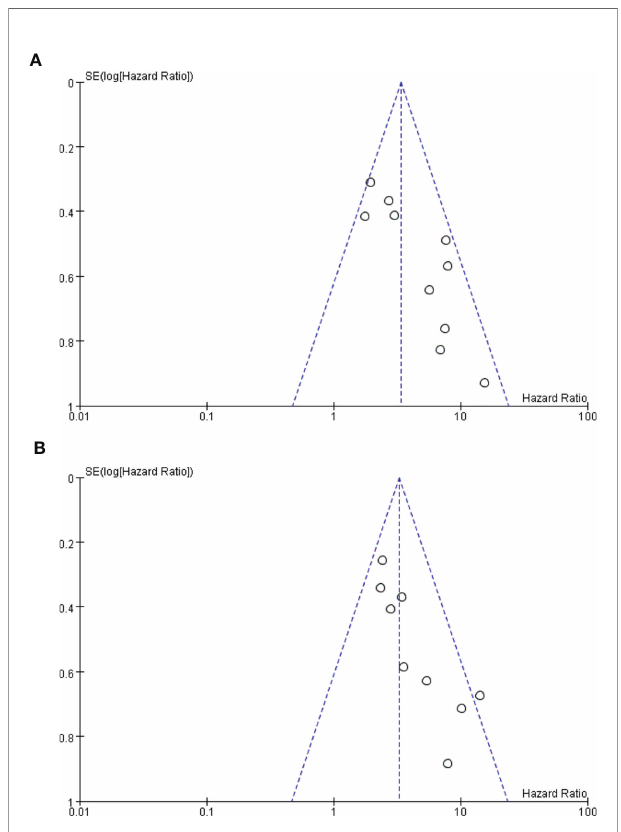
FIGURE 3 | (A, B) Funnel plots. Funnel plot analysis on potential publication bias for overall survival (OS) (A) and progression-free survival (PFS) (B)